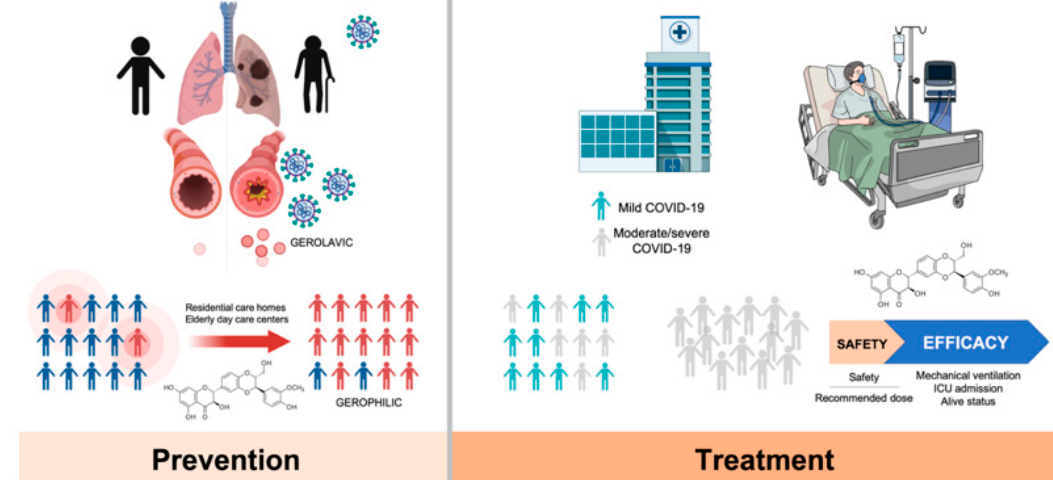
Figure 5. Silibinin in the prevention and treatment of COVID-19. COVID-19 prevention. Severe COVID-19 illness and death is largely more common in the population aged 60 and older. The gerophilic and gerolavic traits of SARS-CoV-2 infection might rely on immunosenescence and other lung-associated cellular senescence phenomena promoting chronic airway remodeling and sustain chronic airway inflammation. The immunomodulatory and senoremediative activities of silibinin might ameliorate the co-morbid features of aging lungs (e.g., chronic inflammation, airway remodeling, function decline) thereby reducing the risk of COVID-19 aggressiveness and lethality in elderly individuals. In frail, elderly individuals with an elevated pre-disposition to experience delayed IFN-I signaling leading to dysregulated inflammatory monocyte/macrophage responses, lung immunopathology, and lethal pneumonia, the direct antiviral actions of silibinin might also be explored as a prophylactic intervention. COVID-19 treatment. An ongoing clinico-translational research study is being conducted at the Catalan Institute of Oncology in Catalonia (Spain) for testing the therapeutic efficacy of silibinin in oncology patients hospitalized with moderate/severe COVID-19. A Jung’s two-stage design for randomized phase II trials with a prospective control was used to estimate the sample size [84]. To keep the sample size small and the study period short, we employed a relatively large type I error ( α = 15%) and short-term outcome variable (i.e., the number of responses as primary endpoint), which will allow for early termination of the study if the silibinin-containing arm fails to show efficacy at the interim analysis. The combination of silibinin plus best supportive care will be considered worthwhile if there is a response rate of 90% in the experimental arm (versus the expected 70% in the control arm [85]). By setting an α level of 0.15, a power of 0.80, a balanced allocation (1:1), and an expected drop-out rate of 10%, the sample size will be 16 patients for both arms to ensure the assessment of response rates in 14 patients in each arm at the first stage. Only if at least two more patients achieve the desirable clinical response in the silibinin-containing arm than in the reference arm, and provided no safety issues are identified, would the clinical trial proceed to the